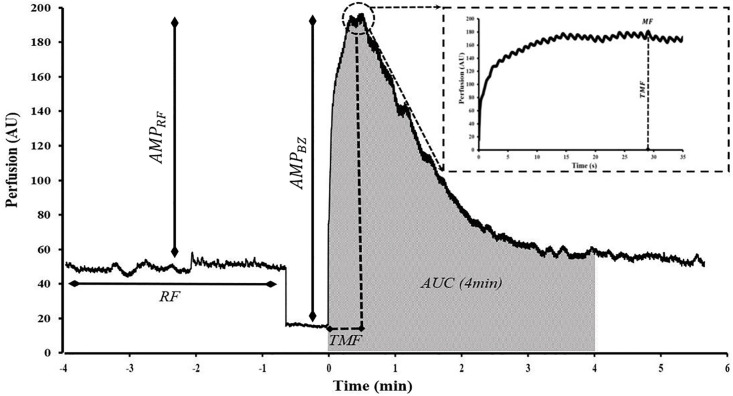
Commonly examined post-occlusive reactive hyperemia parameters shown in a representative PORH response.Resting flow (RF), maximal flow (MF), time to maximal flow (TMF), amplitude of the MF normalized to RF and BZ (AMPRF and AMPBZ) and 4-min post cuff-deflation area under hyperemic curve (4-min AUC) normalized to zero perfusion are shown. Time = 0 corresponds to cuff deflation. Magnified tracing on the top right shows the hyperemic response 30s post-cuff deflation.